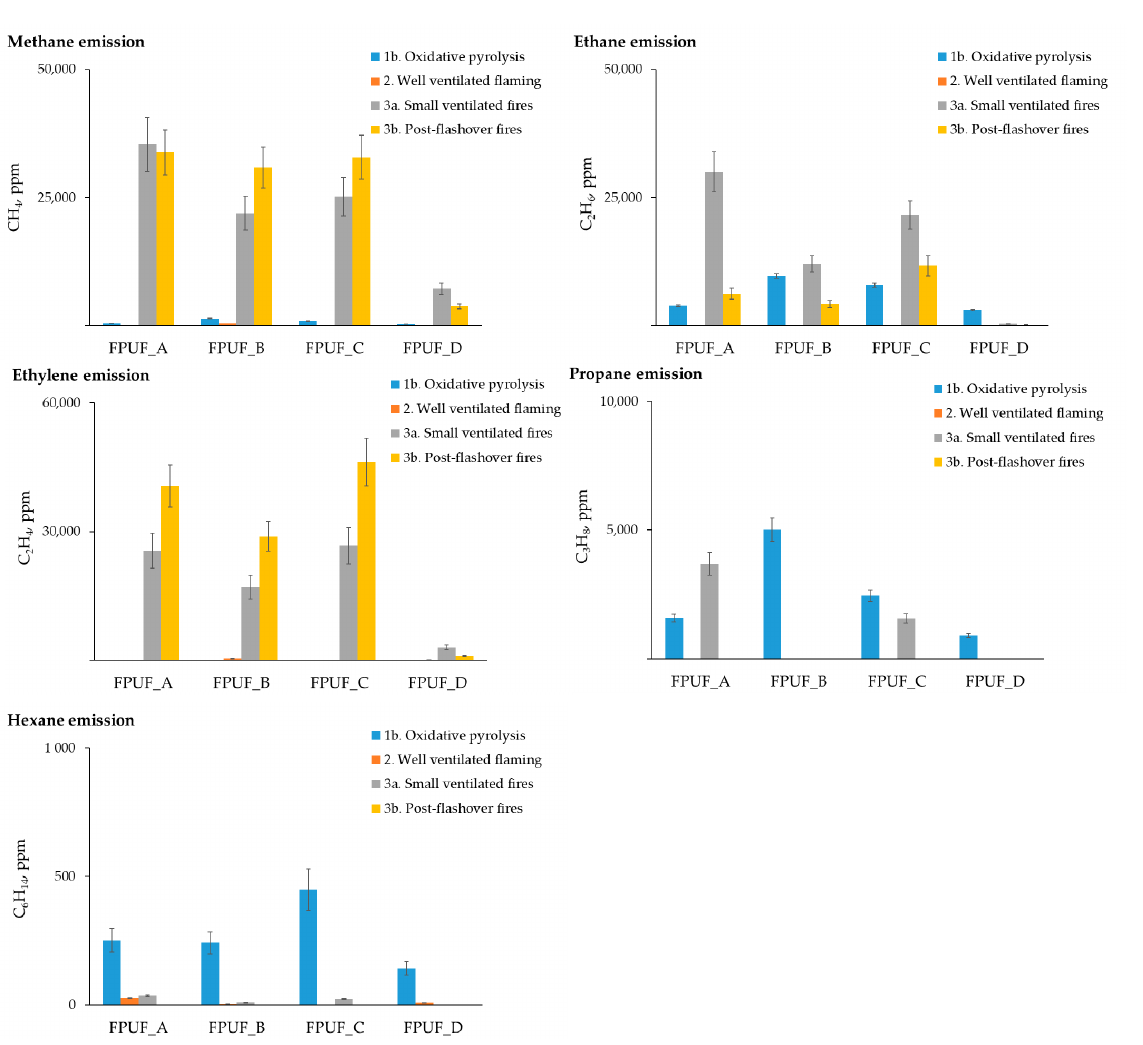
Figure 5. Total concentration of light hydrocarbons from steady ‐ state tube furnace tests produced by flexible polyurethane foams during ~5 min steady ‐ state periods.